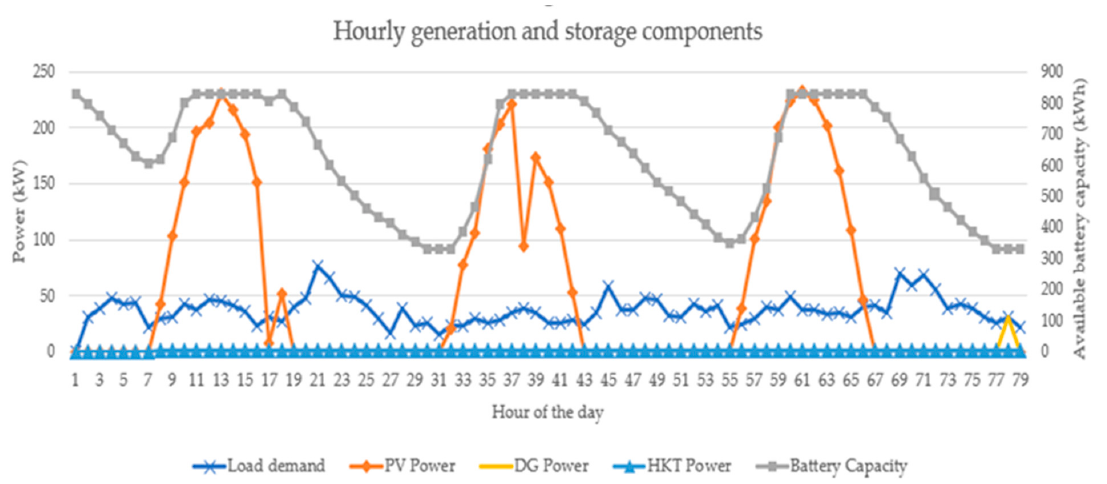
Figure 12. Hourly power pro fi les.